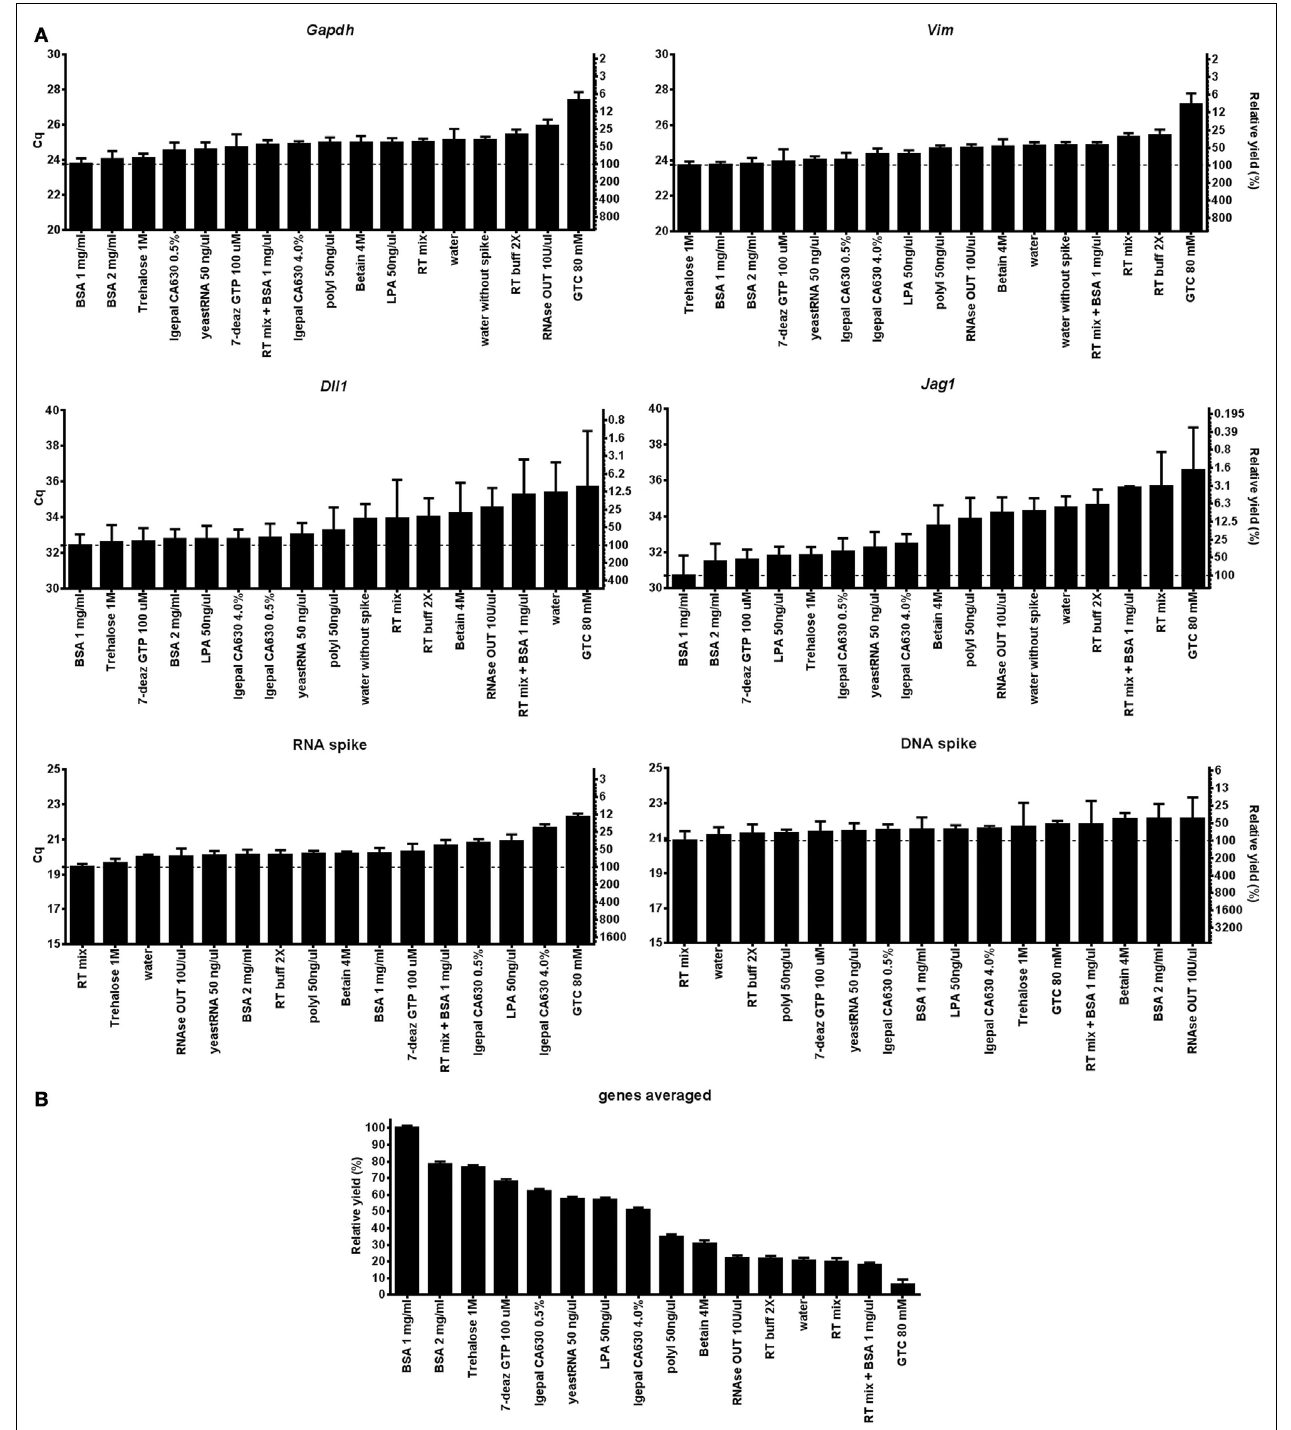
Table S3 in Supplementary Material. (B) Mean cDNA yield of the transcripts. Expressions of Gapdh , Vim , Dll , and Jag1 were averaged and are compared to the overall optimal lysis condition (1mg/ml BSA). Data are shown as mean ± SD ( n = 4). 7-deaz GTP, 7-deaza-2 (cid:48) deoxyguanosine 5 (cid:48) triphosphate lithium salt; GTC, guanidine thiocyanate; LPA, linear polyacrylamide; polyI, polyinosinic acid potassium salt; 2 × RT buffer, 2